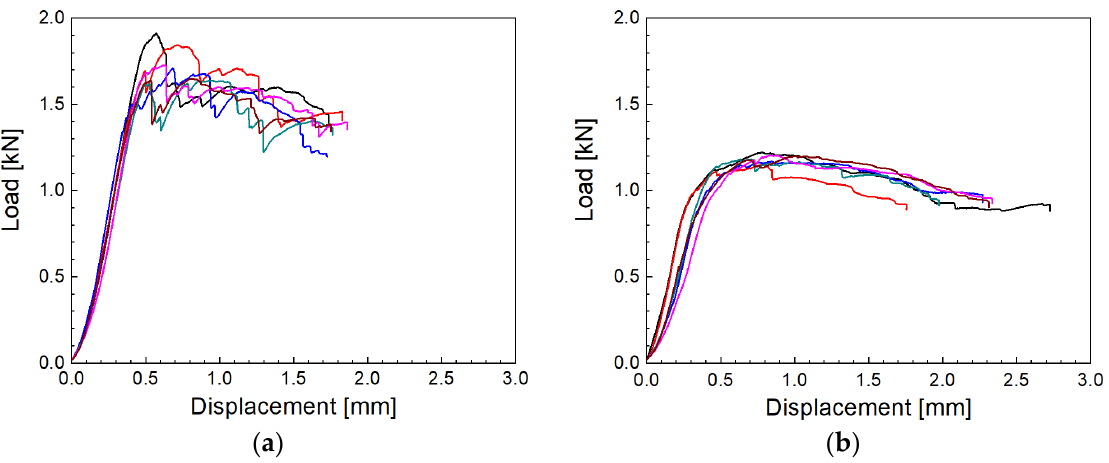
Figure 1. Load-displacements curves as a result of a short-beam shear test for ( a ) fresh and ( b ) the oldest fibers.